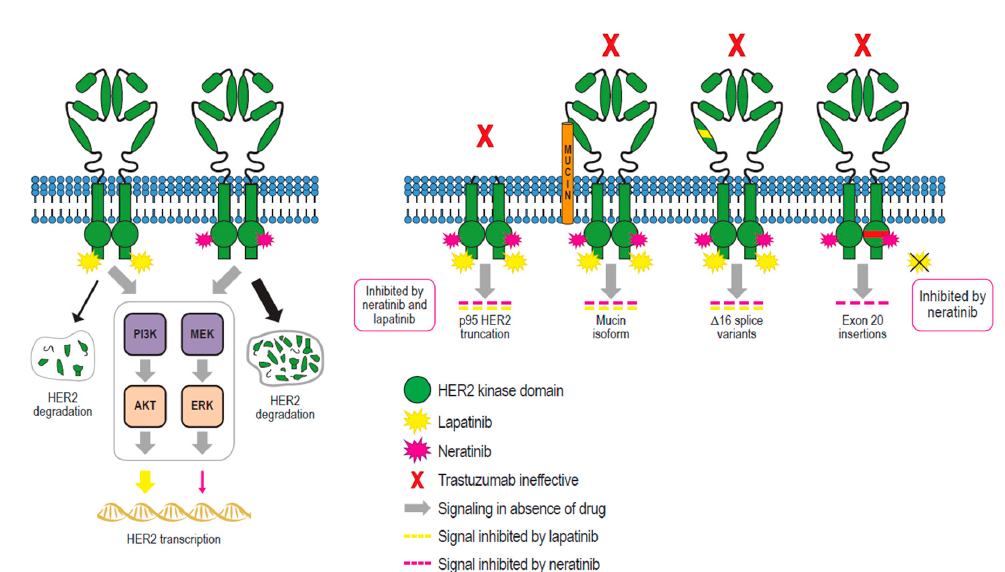
Figure 4. ( A ) Schematic representation of HER2 regulation by lapatinib and neratinib via elevation of HER2 transcription and endocytosis as proposed by Zhang et al. [59]. The differential effects of neratinib and lapatinib are indicated by weighted arrows, with thicker arrows corresponding to a greater effect. Both lapatinib and neratinib increase HER2 transcription through inhibition of PI3K and MAPK signaling, but lapatinib to a greater extent. Both tyrosine kinase inhibitors increase endocytosis and lysosomal degradation of HER2 but neratinib leads to greater HER2 ubiquitylation and degradation than lapatinib [59]. The net effect is an increase in cellular HER2 levels with lapatinib exposure and a decrease in cellular HER2 levels following exposure to neratinib. ( B ) Schematic depiction of HER2-related mechanisms implicated in resistance to trastuzumab, lapatinib, and neratinib. Adapted from Arteaga and Engelmen [79] and references cited therein. Trastuzumab (or pertuzumab / T-DM1) cannot bind truncated p95 HER2. Expression of specific mucin isoforms can abrogate trastuzumab binding. The ∆ 16 HER2 splice variant, which has an in-frame deletion of 16 amino acids (634–649) of exon 16 in domain IV, does not bind trastuzumab. The ∆ 16 HER2 splice variant co-exists